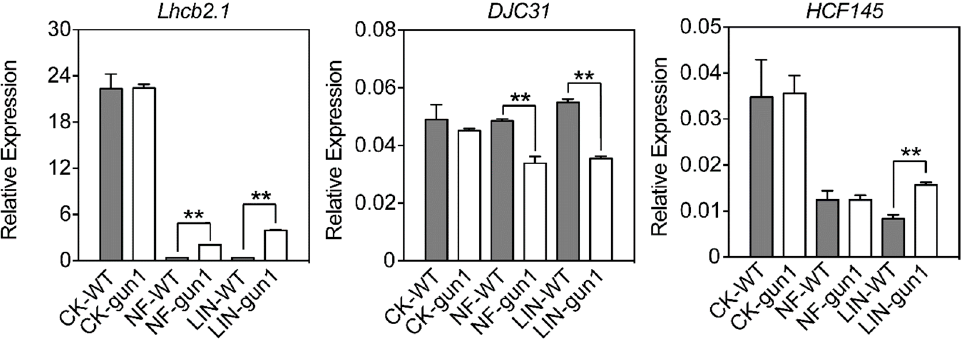
Figure 3. Expression of genes for DJC31 and HCF145 in response to norflurazon and lincomycin treatments. Arabidopsis thaliana Col-0 wild-type (WT) and gun1 mutant seedlings germinated on 1/2 MS plates supplemented with norflurazon (NF, 5 μ M) or lincomycin (LIN, 220 μ g mL − 1 ) under growth condition for 7 d were analyzed. Transcript abundance was determined by qRT-PCR with Actin2 as a reference. Data represent means ± SD ( n = 3). Asterisks indicate significant differences between the WT and gun1 mutant under the same treatment (** p < 0.01, Student’s t